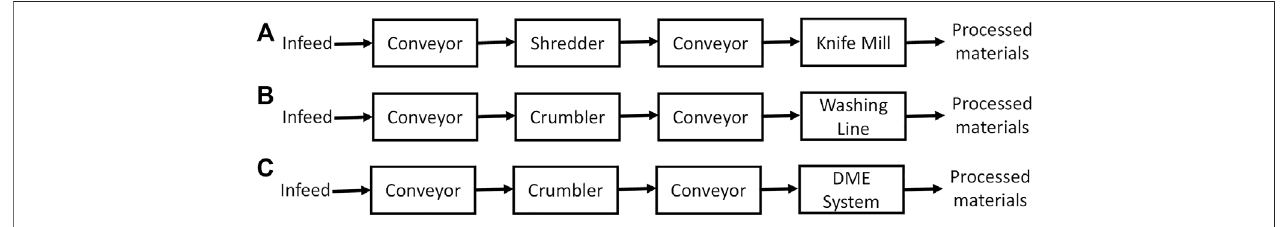
FIGURE 3 | Process fl ows for feedstock pre-processing unit operations. Paper size reduction (A) , plastic size reduction and detergent washing-drying (B) , and plastic DME-based washing (C)